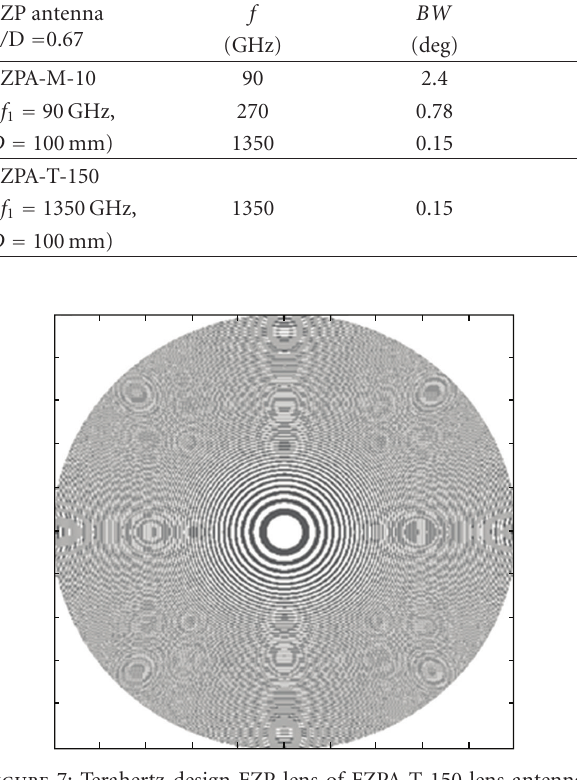
Figure 7: Terahertz-design FZP lens of FZPA-T-150 lens antenna designed at 1350 GHz.